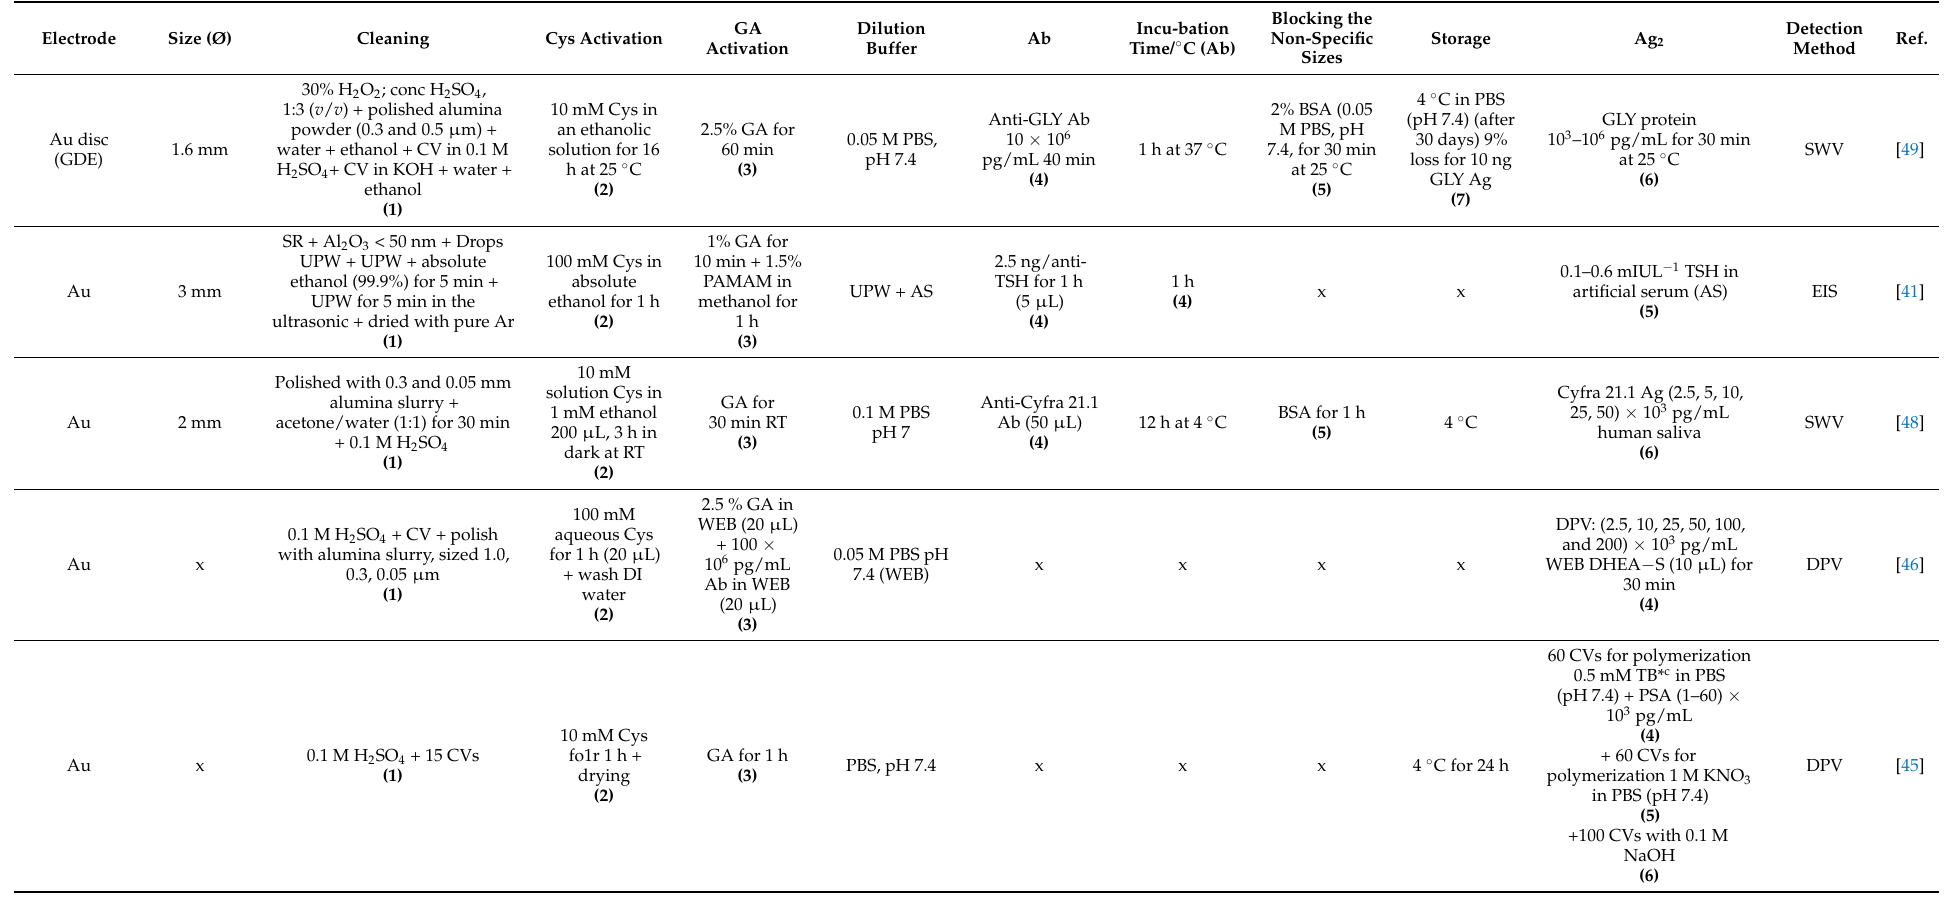
Table 2. Step-by-step (bio)functionalization of supports for electrochemical detection of biomarkers on different solid and flexible substrates.